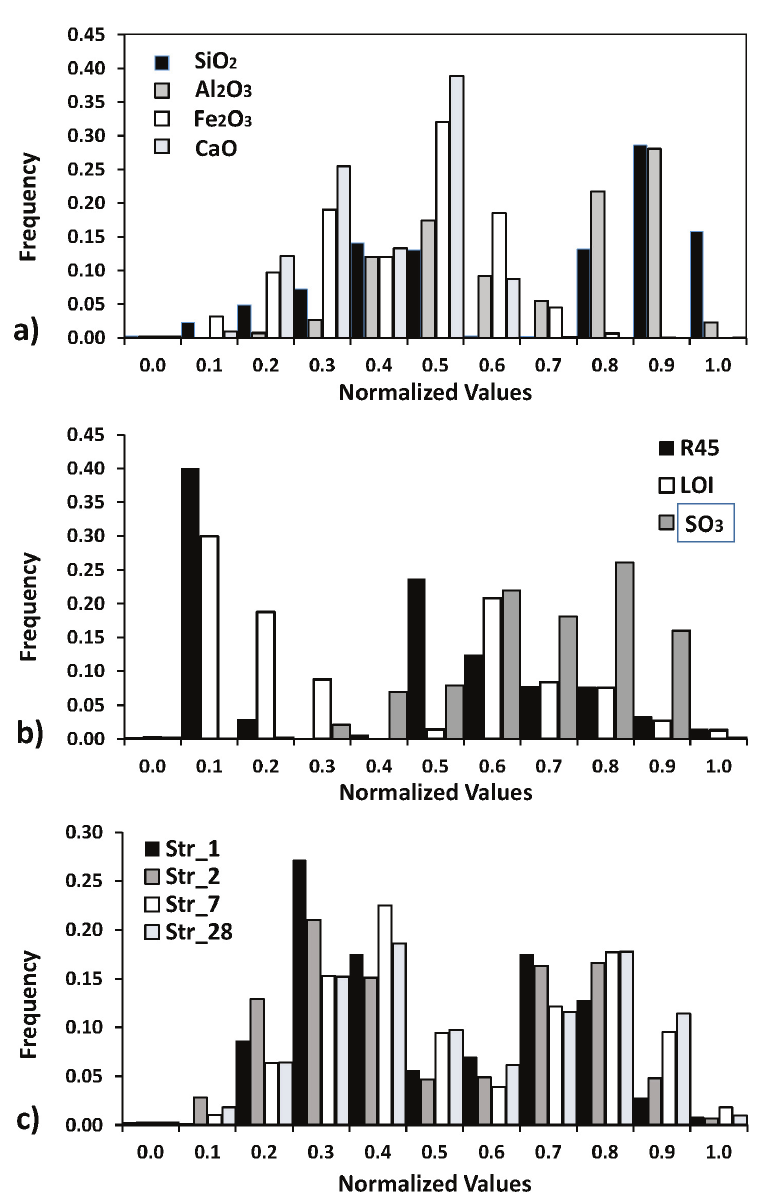
Fig. 1 – Frequency distribution of normalized values of physical, chemical, and mechanical